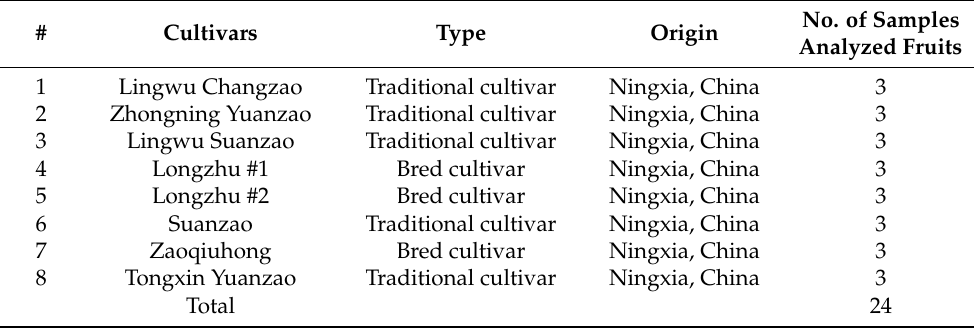
Table 1. List of names, origins, and sources of eight Chinese jujube cultivars used for testing fruit authenticity in the present